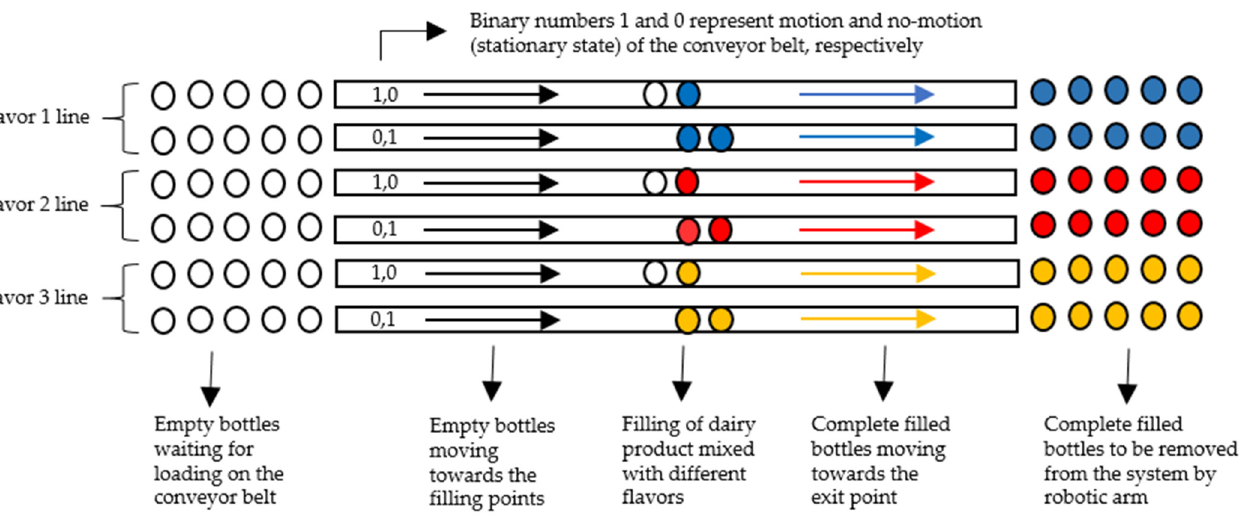
Figure 1. The processing of bottles of required volumes of yogurt and flavors with dedicated filling points for each flavor.